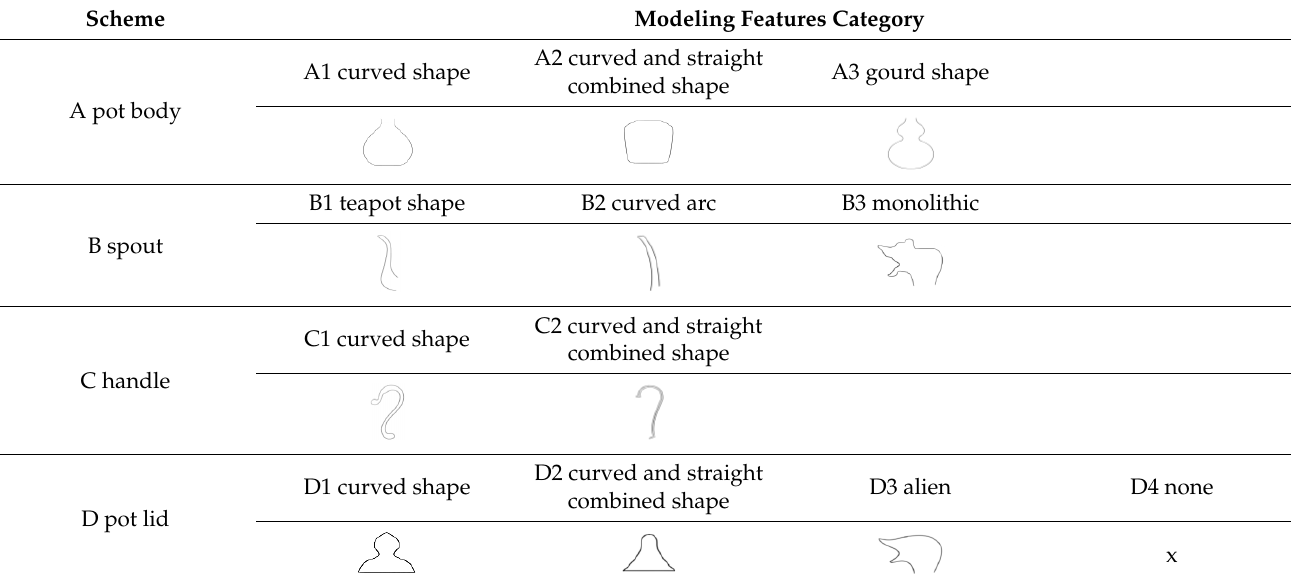
Table 7. Design element library of wine jug shape features.